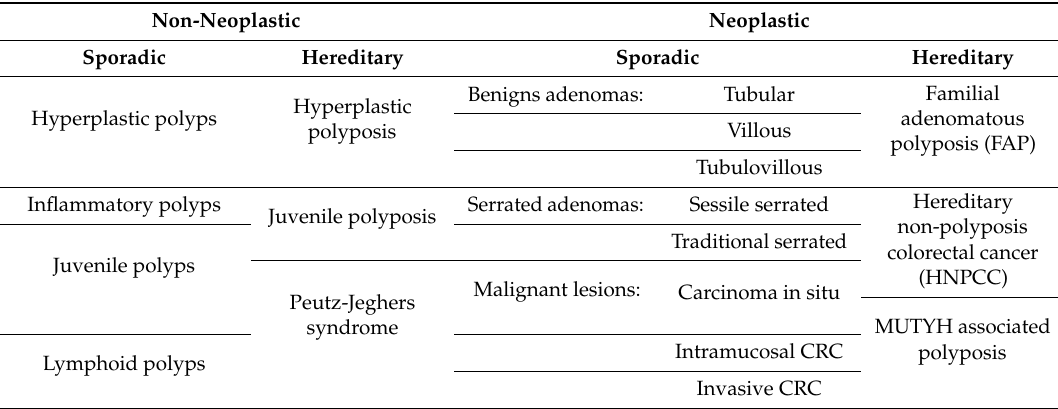
Table 1. Classification of non-neoplastic and neoplastic polyps and polyposis [18].